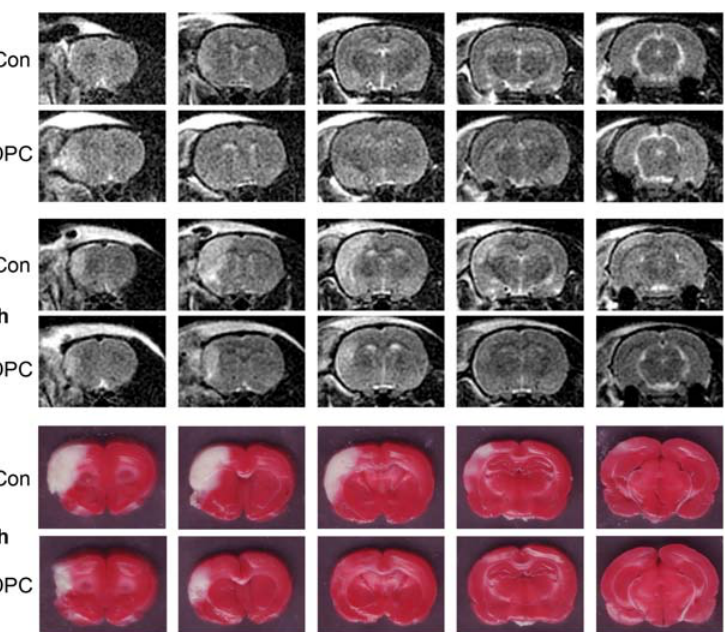
Figure 4. T2-weighted magnetic resonance imaging (MRI) confirmed infarction evolution after stroke and delayed postcondition- ing. Representative MRI images at 5 h (top two rows) and 24 h (middle two rows) from rats subjected to control ischemia and delayed postconditioning after stroke are shown. Control ischemia (con) was induced by 30 min bCCA occlusion combined with permanent dMCA occlusion; delayed postconditioning (DPC) was conducted from 6 h to 9 h by 6 cycles of 15 min release/15 min occlusion of the ipsilateral CCA. TTC staining showed infarction (bottom two rows) corroborated T2 weighted MRI. The rats were euthanized after MRI. Rat brains were sliced into 5 coronal slices and stained with TTC. The infarct region revealed by TTC staining is consistent with that revealed by